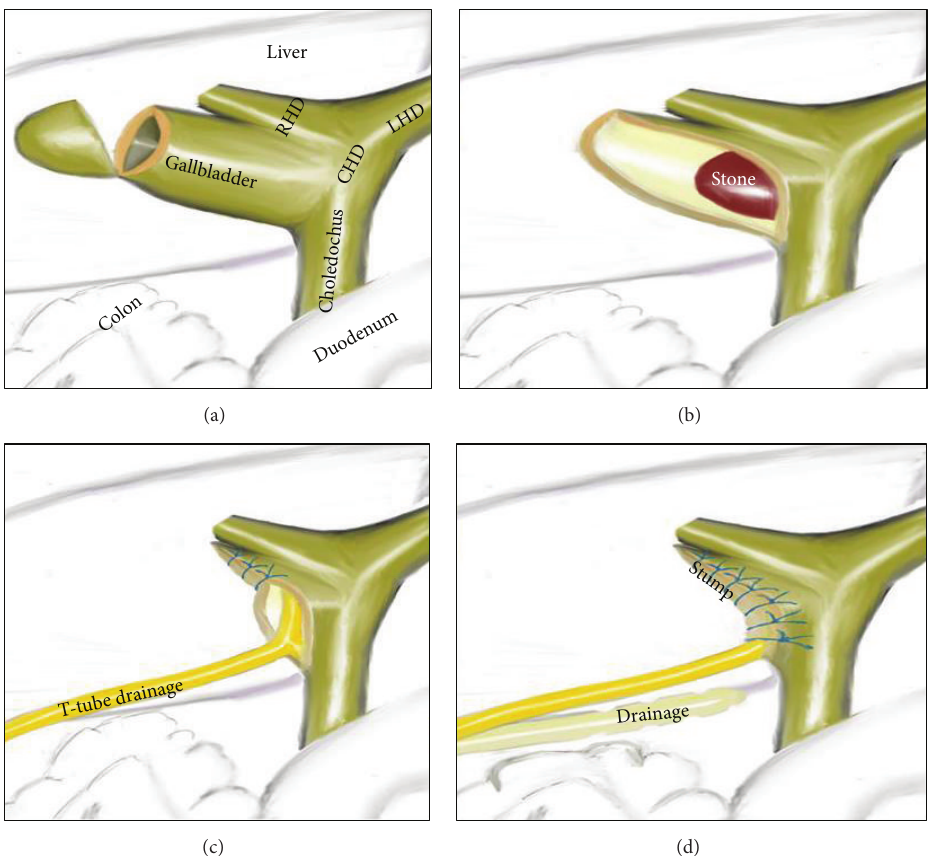
Figure 5: Schematic illustration of this operation. (a) Fundus resection of sclerotic gallbladder. (b) Impacted stone is seen after resection of anterior part of gallbladder and cystic duct. (c) T-tube drainage was placed in choledochus through the anterior opening. (d) Gallbladder stump and choledochus have been repaired over T-tube